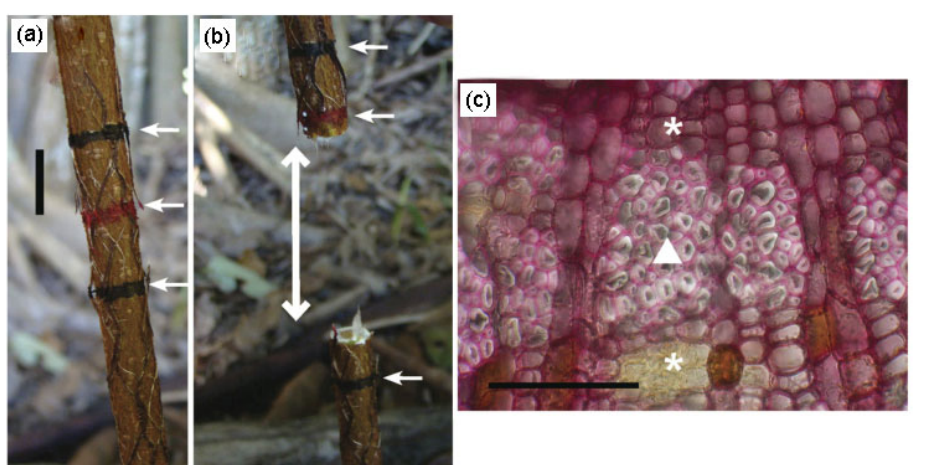
Figure 8. Distribution of reaction tissues (red areas) in various plants and organs [11]. ( a ) Branches of broad ‐ leaved trees [68,69]; ( b ) stem of mangrove seedlings during gravitropic movement [70]; ( c ) pedicles of heavy fruits [63]; ( d ) Aerial roots [64]; ( e ) spines and cladode junction regions of Opuntia [71,72]; ( f ) roots and hypocotyls of geophytes [63,71]; ( g , h ) stems and tendrils of scandent and climb ‐ ing plants [65,73]; ( i ) stems of fiber crops [64,72].